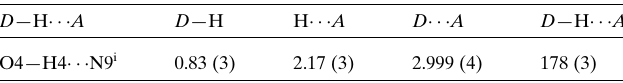
Table 2 Hydrogen-bond geometry (A˚ , (cid:3) ).